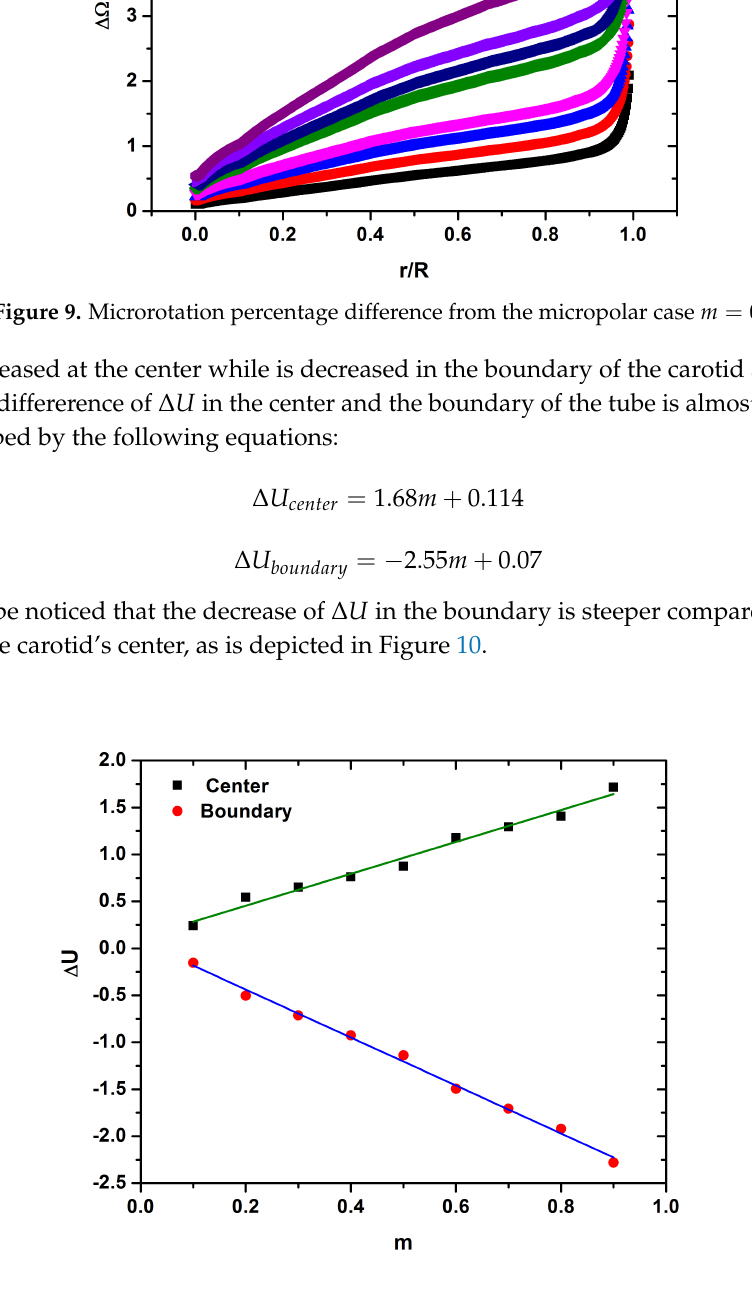
Figure 10. ∆ U in the center of the tube (black squares) and near the boundaries (red dots). Green and blue lines indicates fitting of